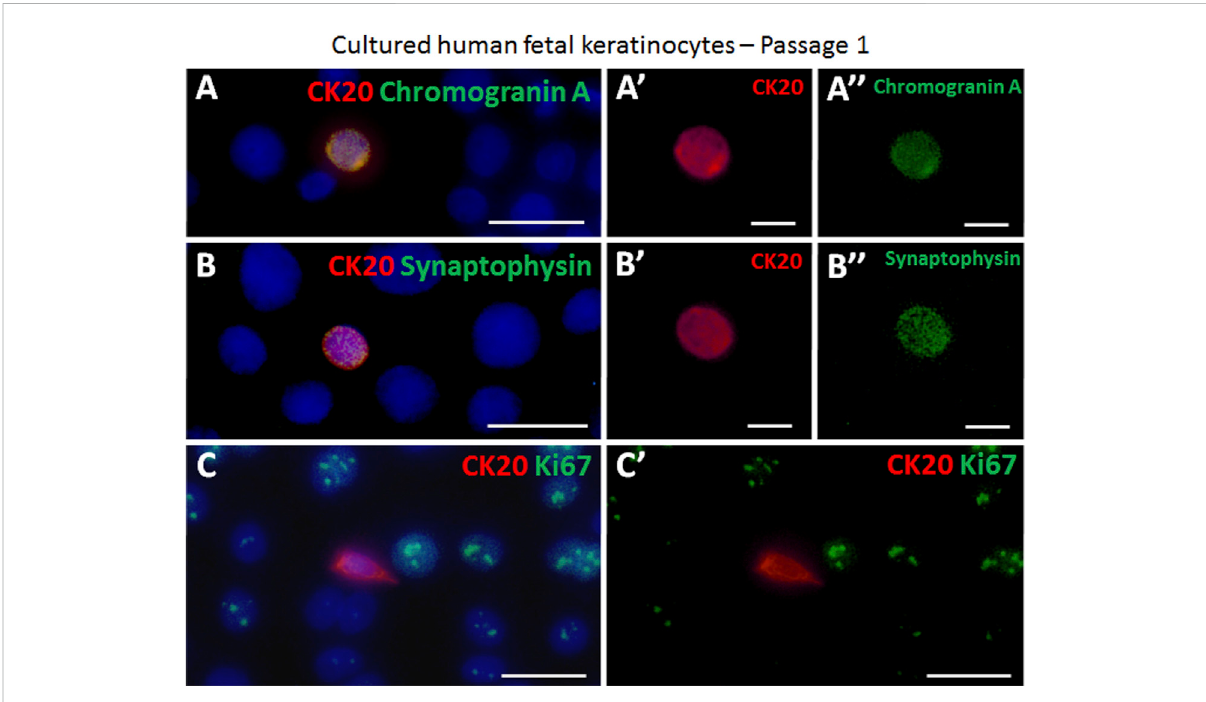
FIGURE 4 Examples of immuno fl uorescence staining of cultured cytospinned epidermal keratinocytes in passage 1. (A,A 9 ,A 0 ) CK20-positive (red) Merkel cell expressed chromogranin A (green). (A 9 ) displays the CK20-positive (red) Merkel cell shown in (A) . (A 0 ) demonstrates the chromogranin A (green) expression in the Merkel cell in (A) . (B,B 9 ,B 0 ) The neuroendocrine marker synapthophysin (green) is expressed in a CK20-positive (red) Merkel cell. B 9 and B 0 show as single staining the CK20 (red) or synaptophysin (green) expression of the Merkel cell displayed in (B) . (C, C 9 ) Ki67 (green) and CK20 (red) expression in cultured cells. The proliferation marker Ki67 is not expressed in the Merkel cell. (C 9 ) depicts Ki67 (green) and CK20 (red) doublestainingwithoutcellnucleiHoechstdyein (C) .Hoechst33342(blue)wasusedtocounterstainnuclei.Scalebars:A,B,C,C ’ =25 μ m;A ′ ,A ″ ,B ′ , B ’’ = 10 μ